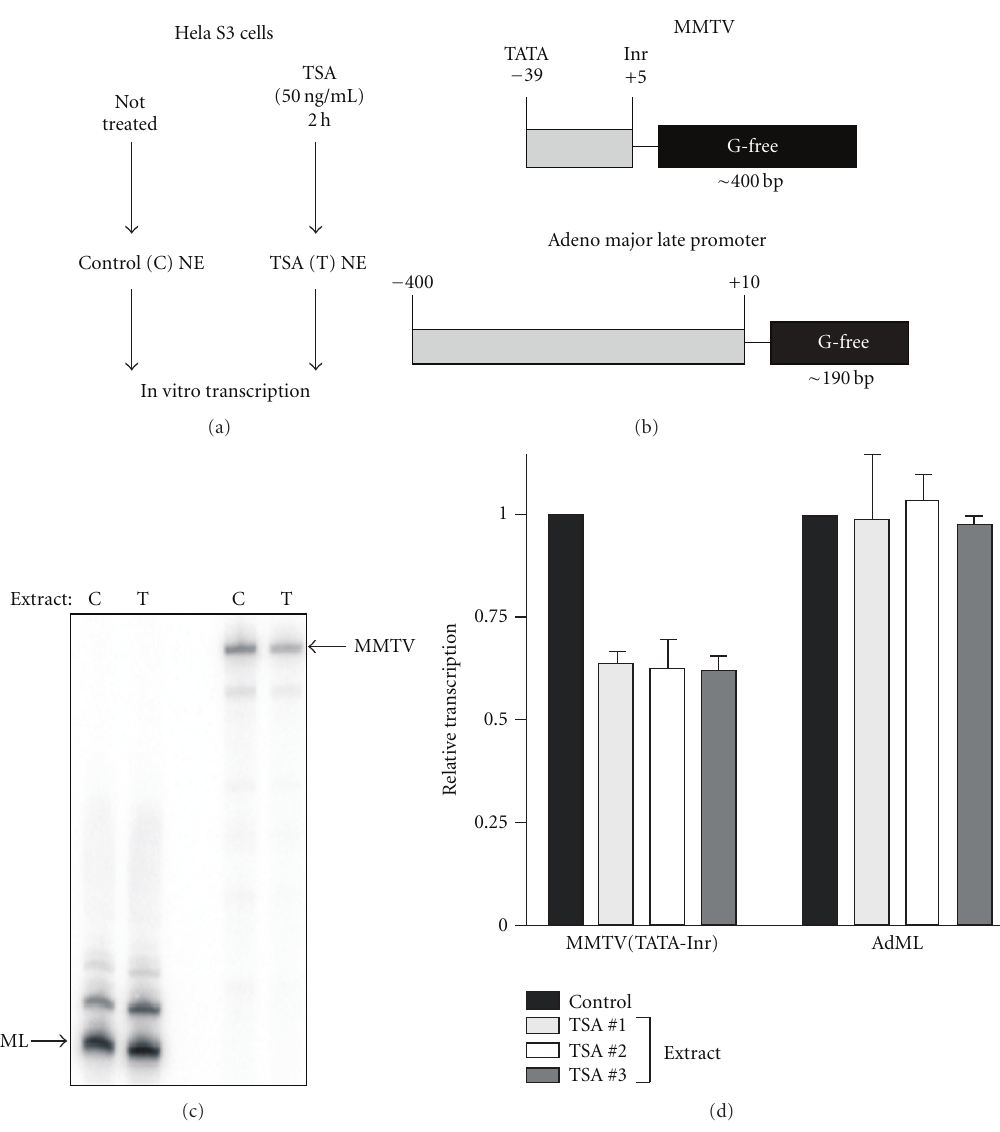
Figure 4: Repression of MMTV transcription by TSA is consistently recapitulated in an in vitro transcription assay. (a) Flow chart for a typical experiment. Nuclear extracts are generated from Hela S3 cells which were either untreated or TSA treated. These extracts were used for in vitro transcription assays with the templates shown in (b). The MMTV template contains the region from the TATA box to the initiator element and a G-free cassette of 400bp. The adenovirus major late (AdML) template contains a promoter fragment from − 400 bp to +10bp with a G-free cassette of 190bp. Results of a typical transcription assay are shown in (c). C-extract from untreated cells (Control). T-extract from TSA-treated cells. (d) shows a graphic representation of assay results using three independent sets of extracts. Each extract was assayed with each template at least three times. Transcription levels in the extracts from TSA-treated cells are expressed relative to those in the corresponding extracts from untreated (control)